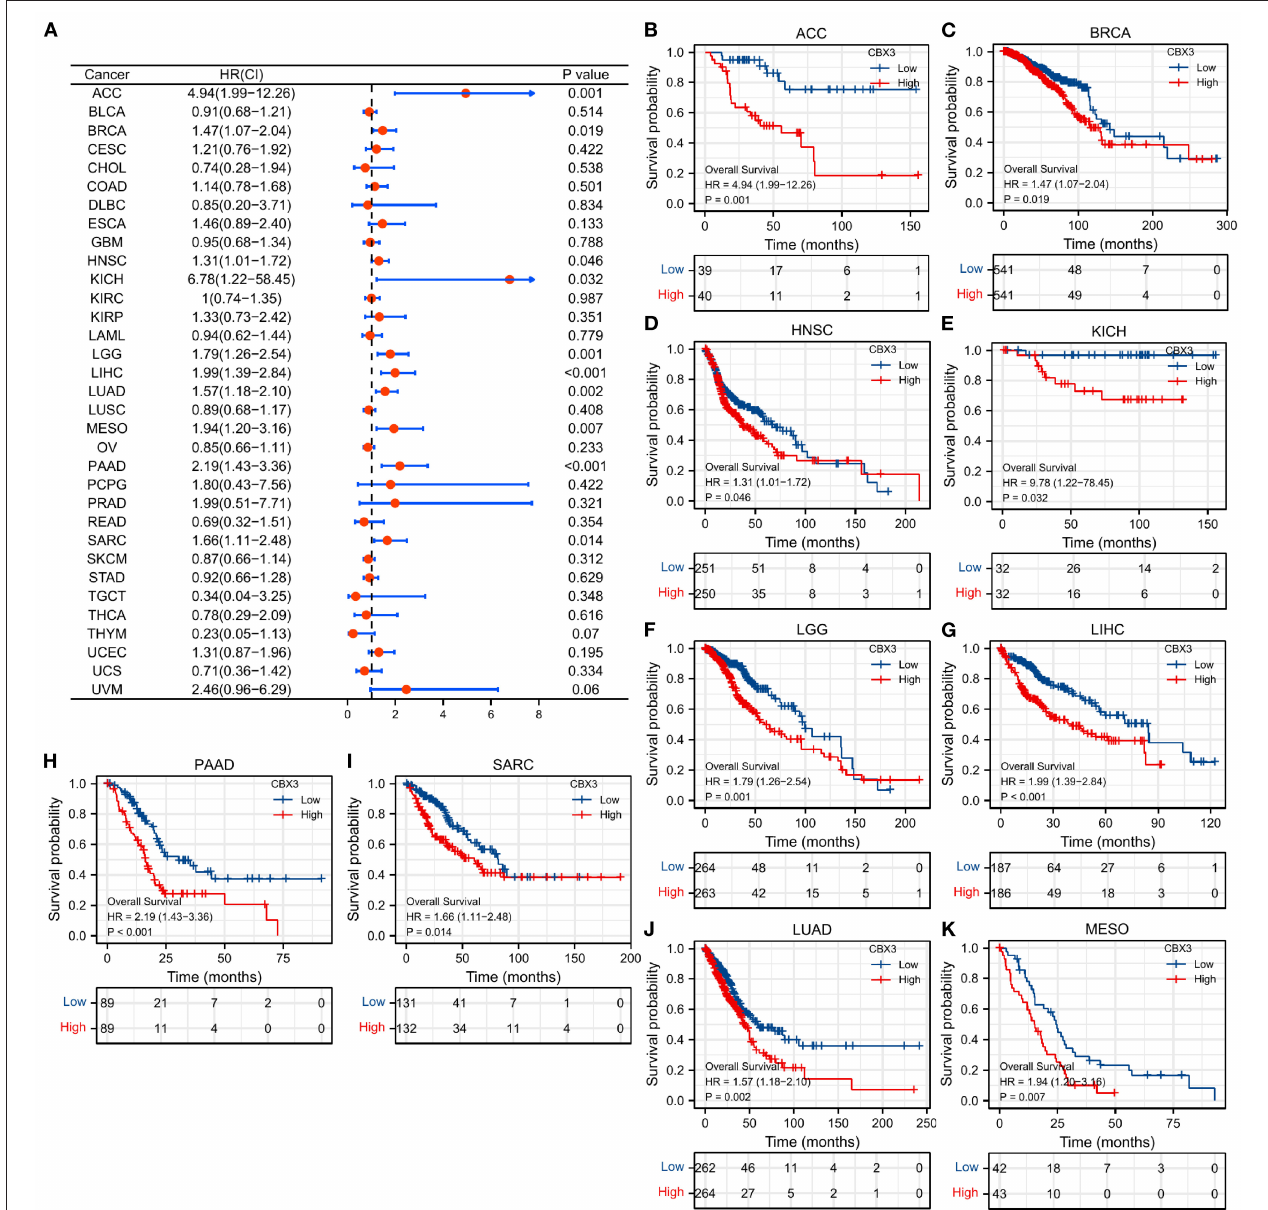
FIGURE 4 | The relationship between the expression of CBX3 and OS. (A) Forest map of the link between CBX3 expression and OS in 33 kinds of tumors. (B–K) KM analysis of the correlation between CBX3 expression and OS.